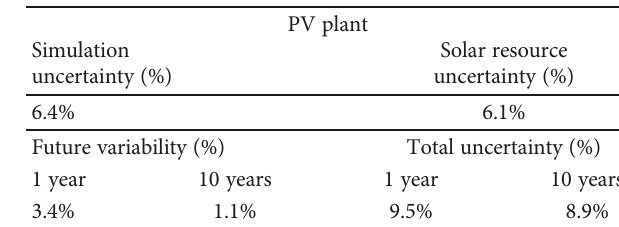
Table 10: The uncertainty fi gures considered for the